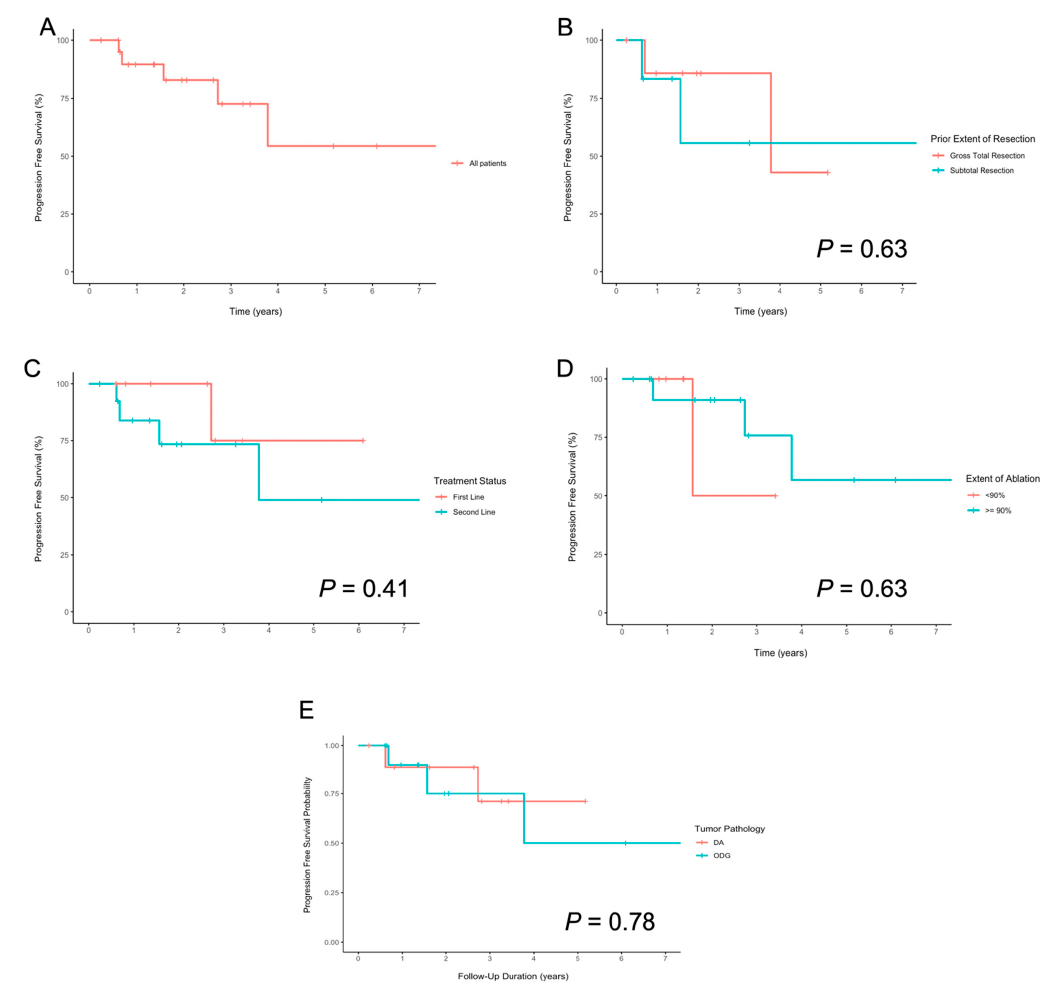
Figure 2. Kaplan–Meier plots showing progression-free survival ( A ) overall and stratified by ( B ) extent of prior resection, ( C ) first line versus salvage, ( D ) extent of ablation, and ( E ) tumor pathol- ogy. Table 4. PFS stratified by extent of resection, treatment status, extent of ablation, and pathology. Variable